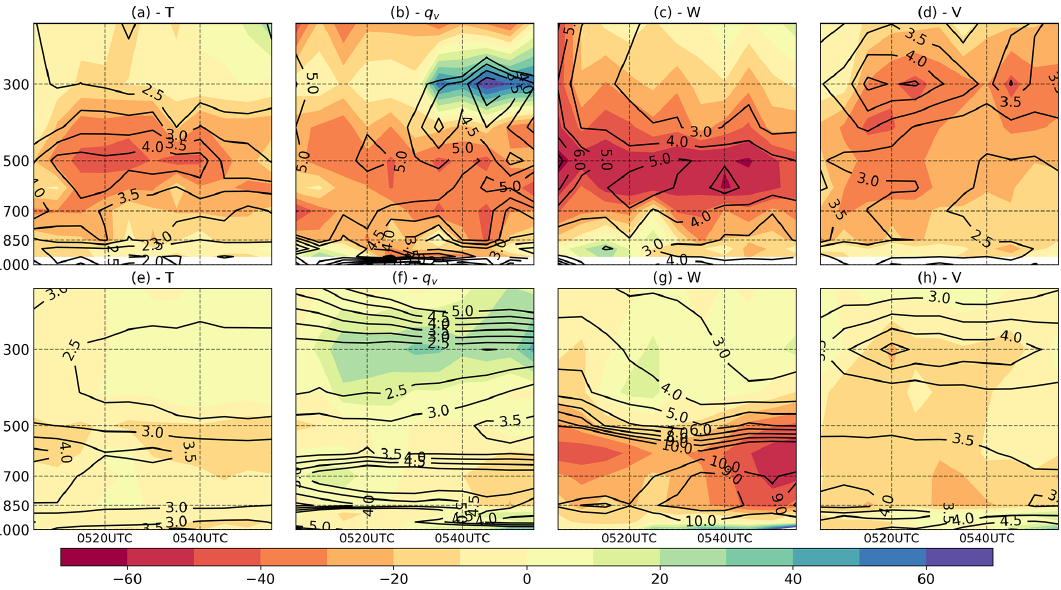
Figure 6. Time vertical cross section of KLD for 5MIN (contours; 10 − 2 ) and the relative difference for 30SEC (shaded), averaged over the (a–d) precipitating ( > 30dBZ) and (e–h) non-precipitating ( < 0dBZ) grid points for (a, e) temperature, (b, f) specific humidity, (c, g) vertical velocity, and (d, h) meridional